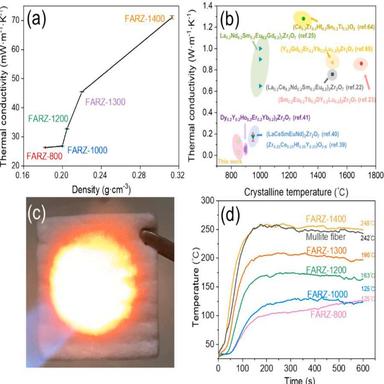
(a) Thermal conductivities of the FARZ as a function of density, (b) thermal conductivities at room temperature in air and crystalline temperature for high entropy materials, (c) optical and (d) image of time-dependent temperature evolution on the back side of the FARZ and mullite fiber exposed to a butane blowtorch flame.